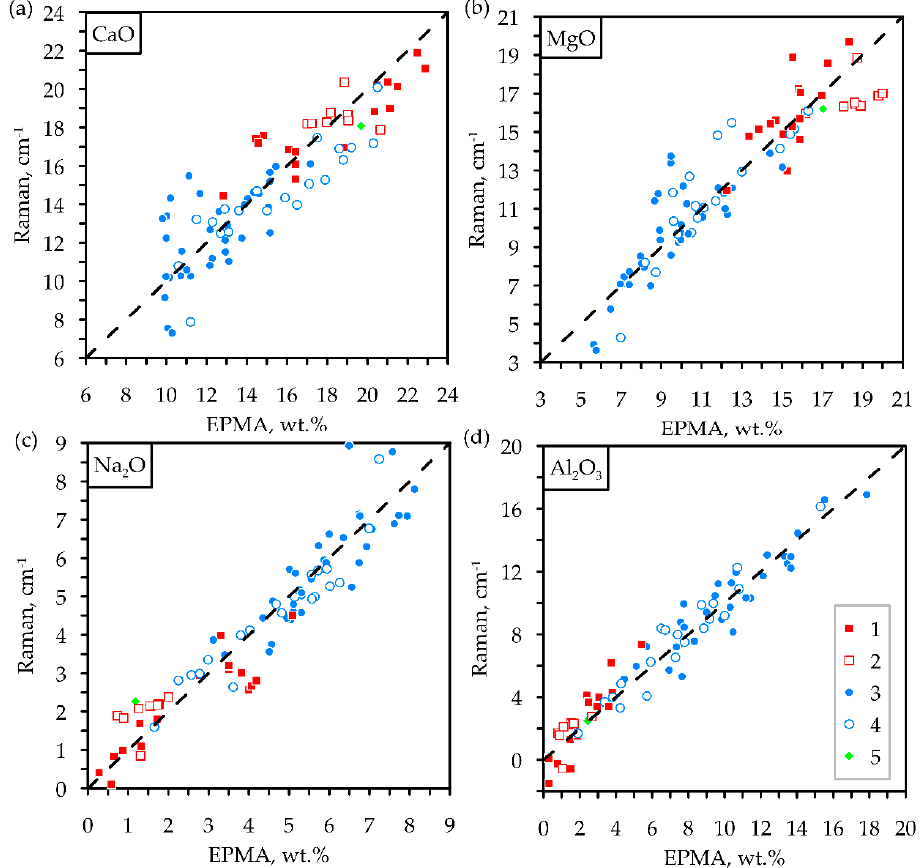
Figure 5. The convergence of CaO ( a ), MgO ( b ), Na 2 O ( c ), and Al 2 O 3 ( d ) contents in clinopyroxenes determined by EPMA and calculated from Raman spectroscopy by using the parameters of the regression equations: 1—peridotite clinopyroxene inclusions in diamonds, 2—clinopyroxenes from peridotites, 3—eclogite clinopyroxene inclusions in diamonds, 4—clinopyroxenes from eclogites; 5—clinopyroxene inclusion in diamond with transitional composition [2]). The dashed line shows ideal convergence (EPMA = Raman).